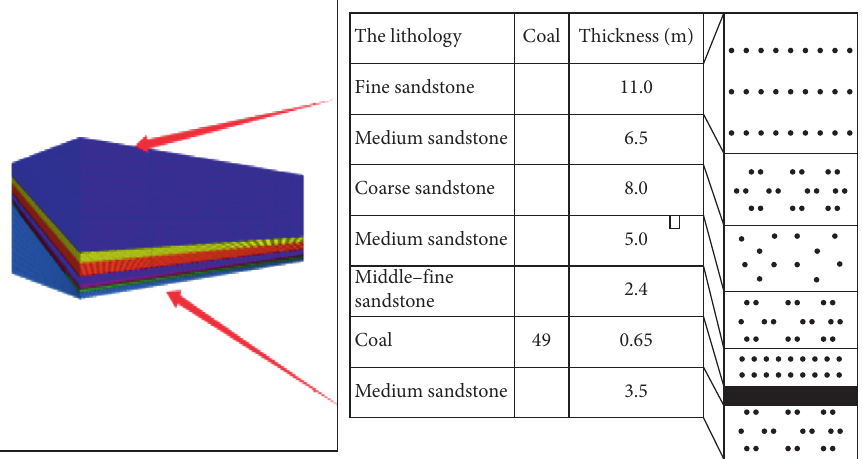
Figure 2: FLAC 3D model of the third left mining face.